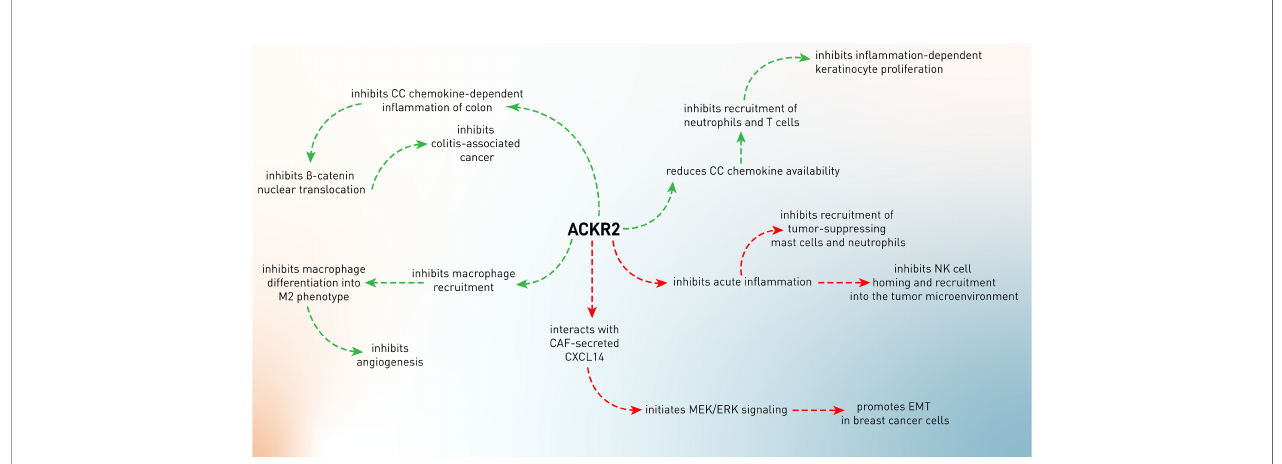
FIGURE 2 | The con fl icting role of ACKR2 in tumor development. The green arrows indicate the tumor-suppressing role of ACKR2, while its tumor-supportive roles were shown by the red